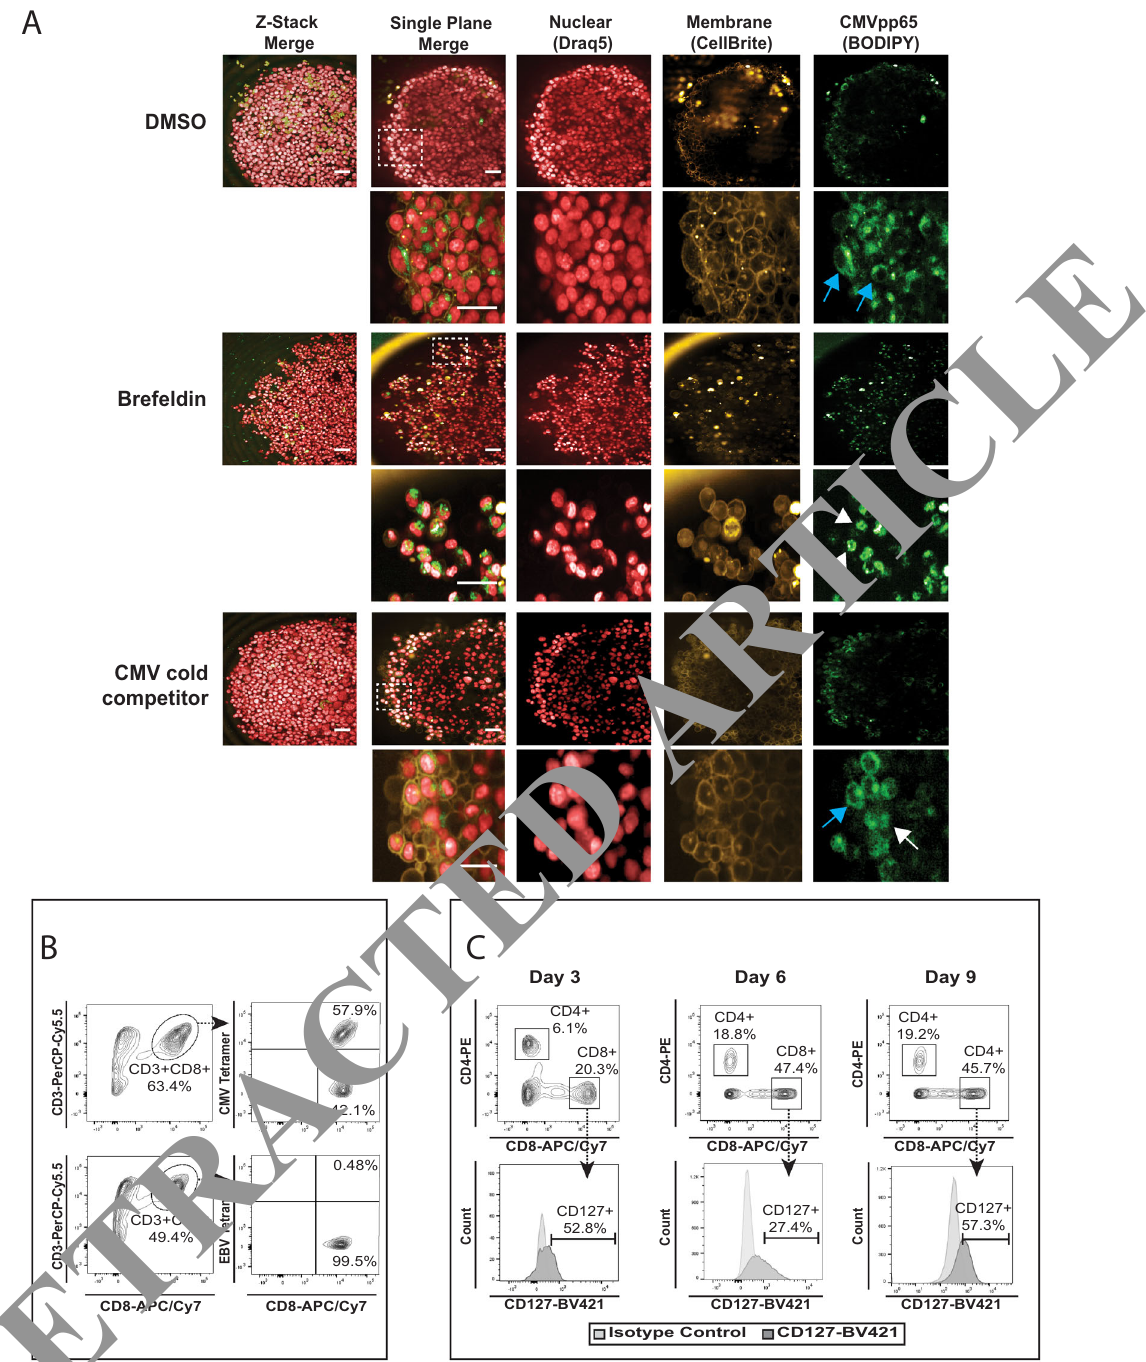
Fig. 2 Characterization of tumor cell antigen presentation and T-cell phenotyping. a CEF viral antigens are presented on the cell surface membranes of HCT116 cells within a tumor spheroid. HCT116 tumor spheroids were loaded with CMVpp65 viral antigen conjugated to a BODIPY-488nm fl uorochrome and treated with either Brefeldin (a protein transport inhibitor), DMSO (vehicle control), or an unlabeled CMV competitor peptide (CMV cold competitor). Spheroids were stained with a cell membrane dye (CellBrite) and a nuclear dye (Draq5) to identify the cellular localization of CMV-BODIPY peptides. Spheroids were imaged comprehensively in a large z -stack and then single planes were more closely scrutinized for CMV-BODIPY membrane localization. Blue arrows indicate membrane-localized CMV-BODIPY peptides and white arrows indicate cytoplasmic CMV-BODIPY peptides. Scale bar equals 60 µ m. b Antigen-speci fi c T-cell priming reveals pMHC-reactive memory T-cells. Human donor PBMCs were stimulated with either CMVpp65 or EBV-BMFL1 viral peptides and expanded for 7 days in culture. Flow cytometry analyses of CD3 + CD8 + T-cell populations reveal binding of TCRs only to CMV tetramers and not EBV tetramers, indicating a CMV-reactive memory T-cell population had been selected and expanded. c Phenotyping of T-cells used for the spheroid- killing screen. PBMC cultures stimulated with CEF viral peptides and expanded in IL-2, then in IL-2, IL-4, and IL-7 were subjected to fl ow cytometry T-cell phenotyping at days 3, 6, and 9 post-stimulation. CD8 + CD127 + T-cells indicate desirable memory effector T-cell population for